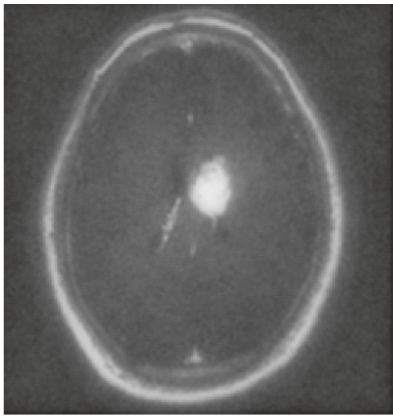
Figure 11: Novel Woelfel filter